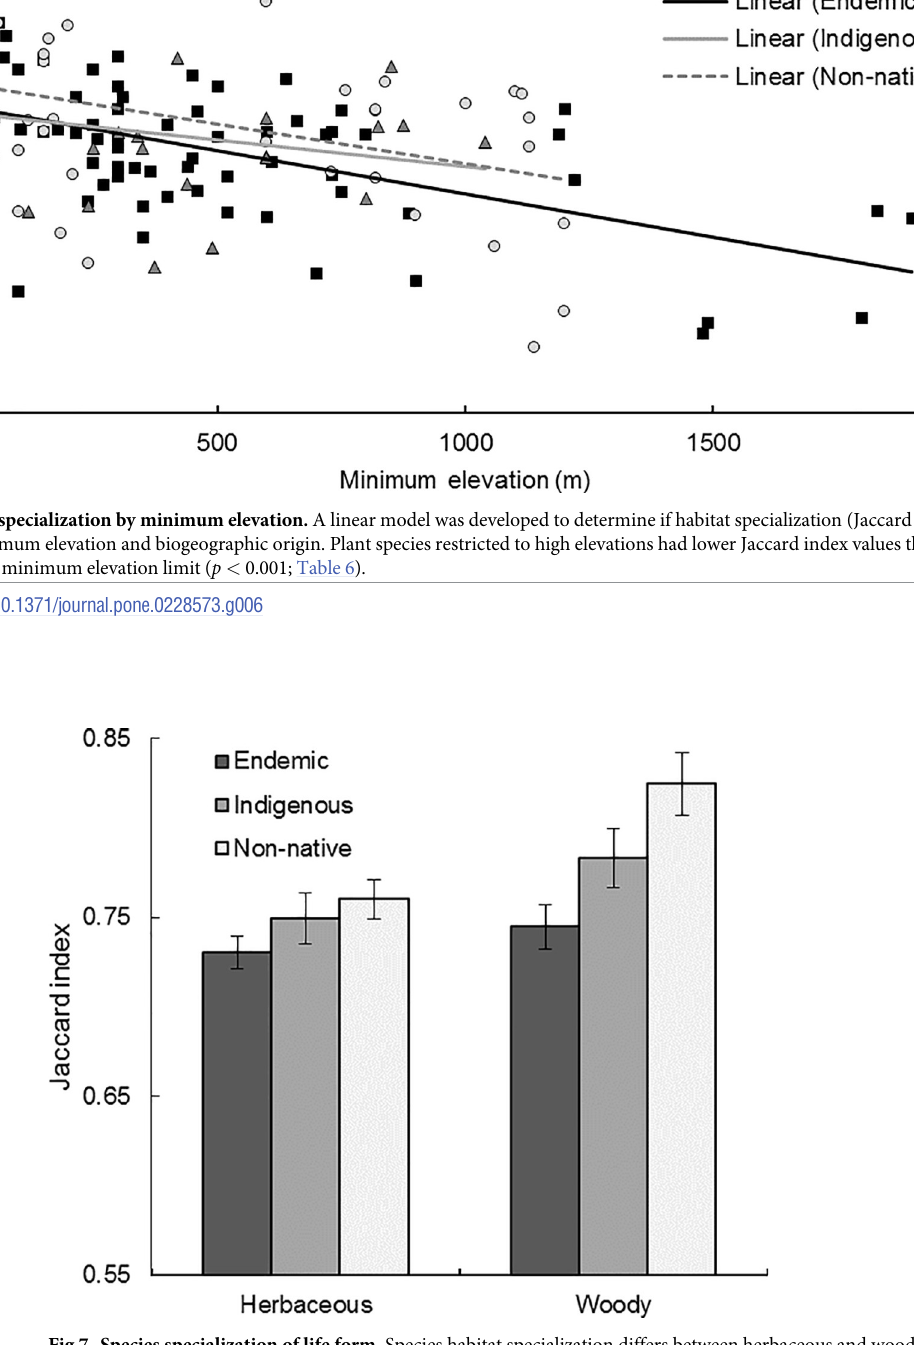
Fig 7. Species specialization of life form. Species habitat specialization differs between herbaceous and woody plant life forms ( p = 0.004) when controlling for biogeographic origin (Table 5). This pattern is most evident in non-native species. Mean values and standard errors are